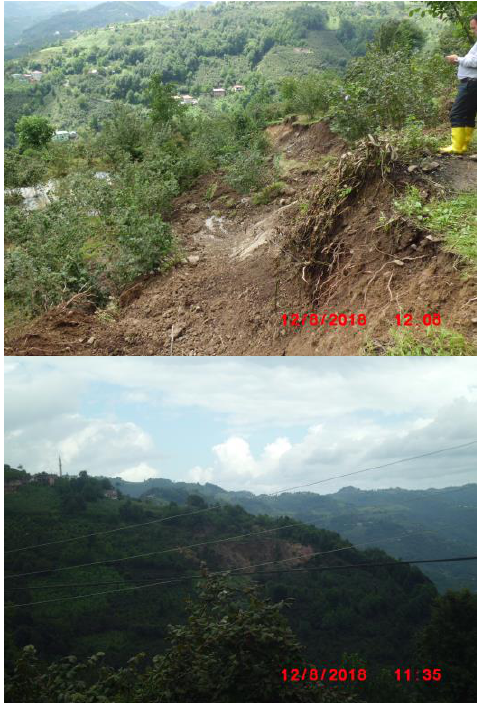
Figure 1. Example views of the landslides triggered during the extreme meteorological event occurred in Ordu in